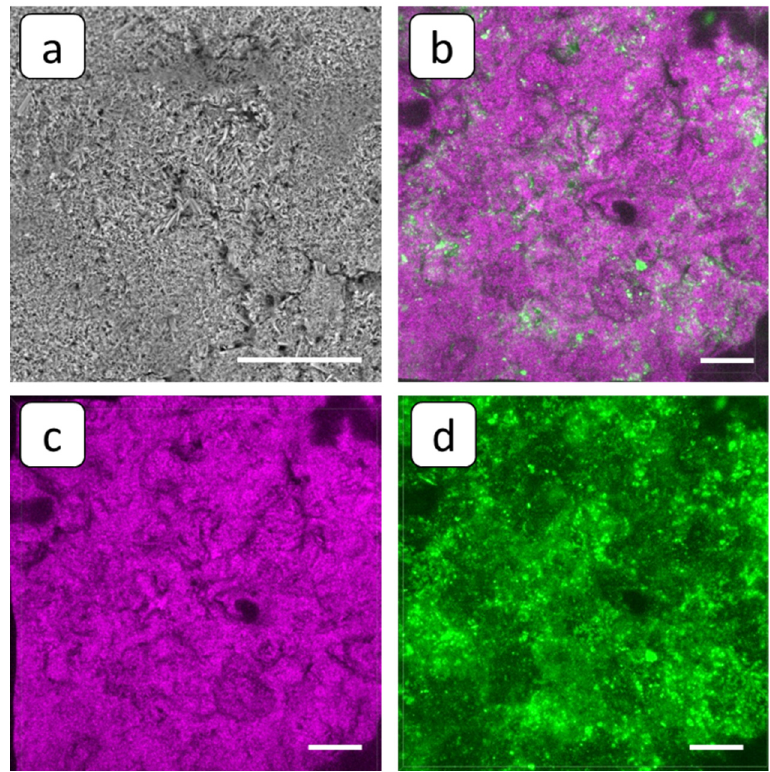
Figure 10. SEM ( a ) and FM 3D images ( b – d ) of the cation-exchange membrane MK-40 after the experiment with run in the presence of HEDP-F, superposition of fluorescent and reflected light ( b ), and the same view in reflected ( c ) and fluorescent ( d ) light. Scale bar: 100 µm.